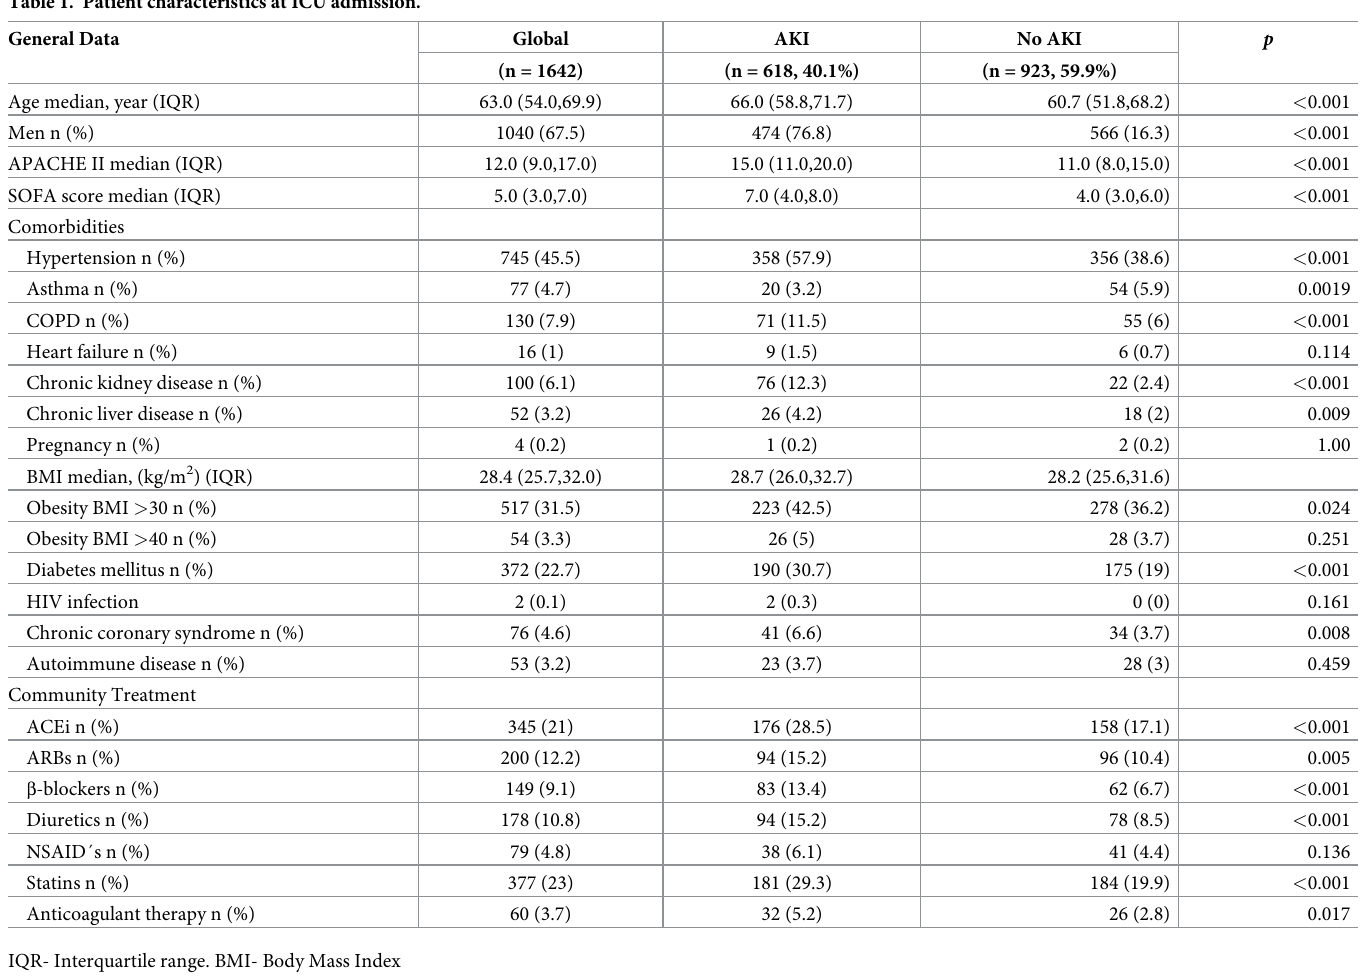
Table 1. Patient characteristics at ICU